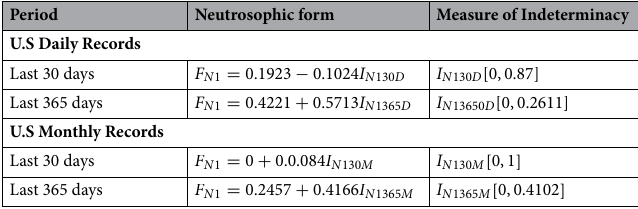
Table 3. Neutrosophic analysis of F N 1 ǫ [ F L 1 , F U 1 ] two